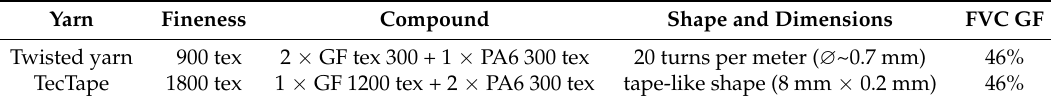
Table 2. Yarn materials. Fiber volume content (FVC), glass-fiber (GF), polyamide (PA).